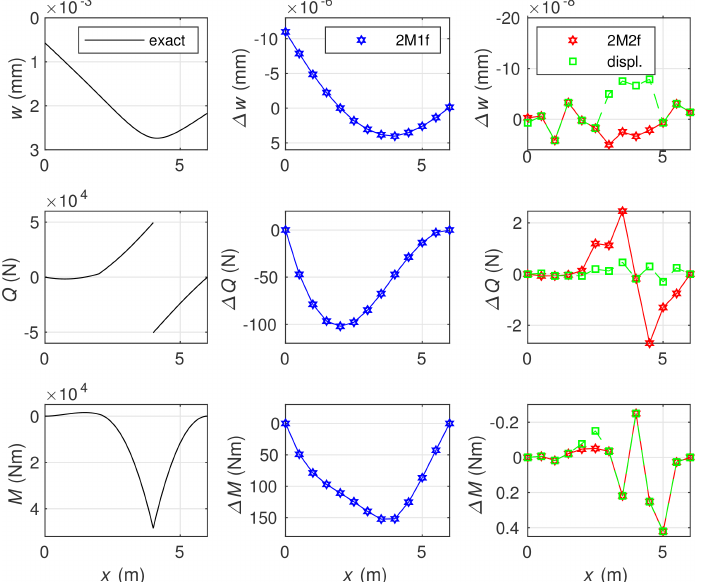
Figure 9. ( Left diagrams ): the deflection, shear force, and bending moment, the exact solution. The approximation solution errors for the deflection, shear force, and bending moment obtained by the 2M1f element ( middle diagrams ), and the 2M2f and the displacement-based element 2d3r ( right diagrams